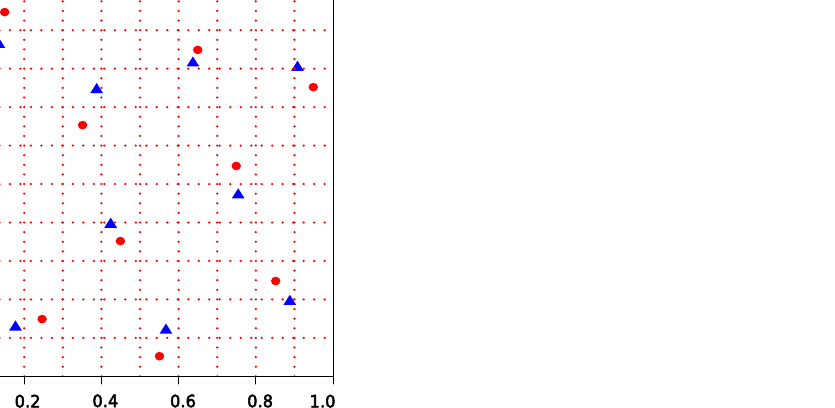
is indeed a central Latin 10 − 4 ,1